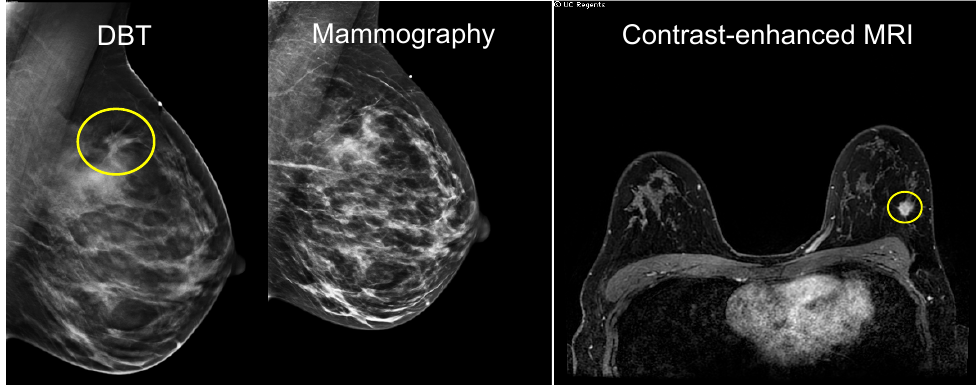
Figure 1. An invasive ductal carcinoma (IDC) presenting as palpable lump, best seen on tomosynthesis slices of DBT (left), with asymmetry and architectural distortion. The heterogeneously dense breast tissue obscures the finding on the 2D mammographic image (center). Ultrasound (not shown) demonstrated a hypoechoic lesion and was redemonstrated by contrast-enhanced MRI with an irregular mass measured at 1.2 × 1.1 × 1.4 cm (right).